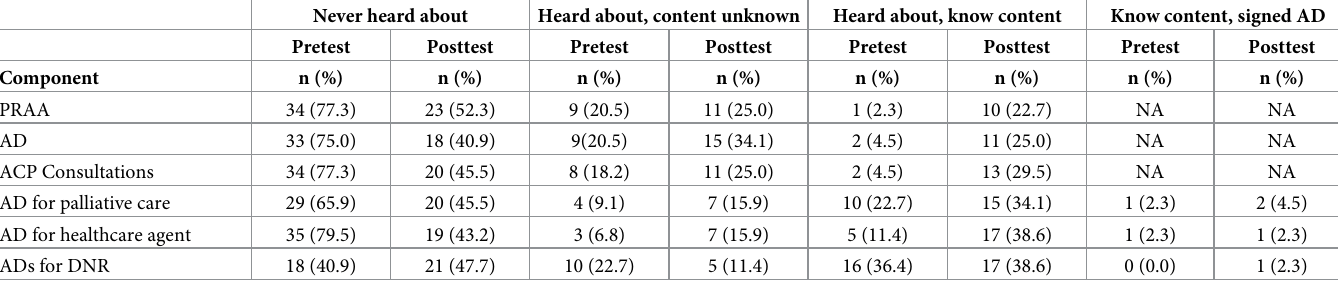
Table 2. Familiarity with components of ACP for PWCIs (n = 44), pre-intervention (pretest) and post-intervention (posttest).